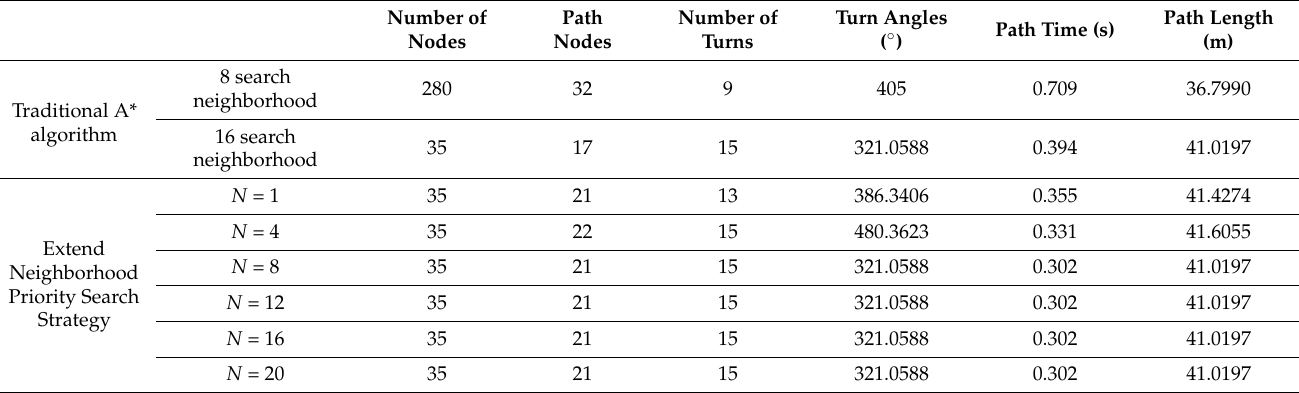
Table 4. The influence of the selection of N value on the performance of the path planning algorithm. Number of Path Number of Turn Angles Path Time (s) Nodes Nodes Turns ( ◦ )